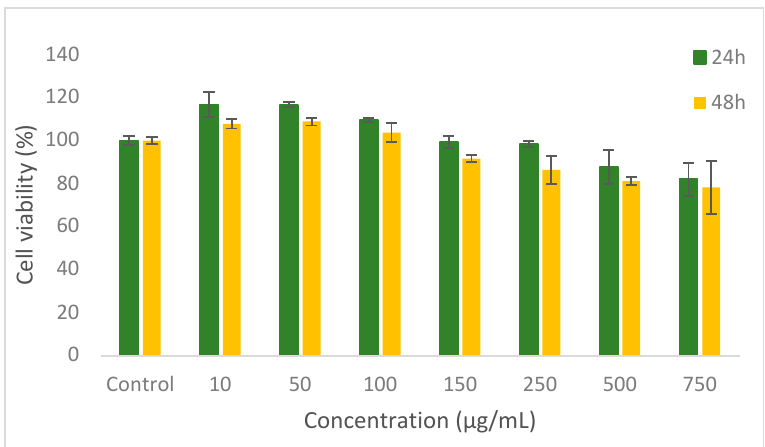
Figure 2. Cell viability of L929 fibroblasts cultivated in the presence of vegetal extracts, onion for 24 h and 48 h, respectively, determined by NR assay. The results were expressed as percentage relative to the control culture (untreated), considered 100% viable. The values represent mean ± SD ( n = 3). p < 0.05, compared to control.